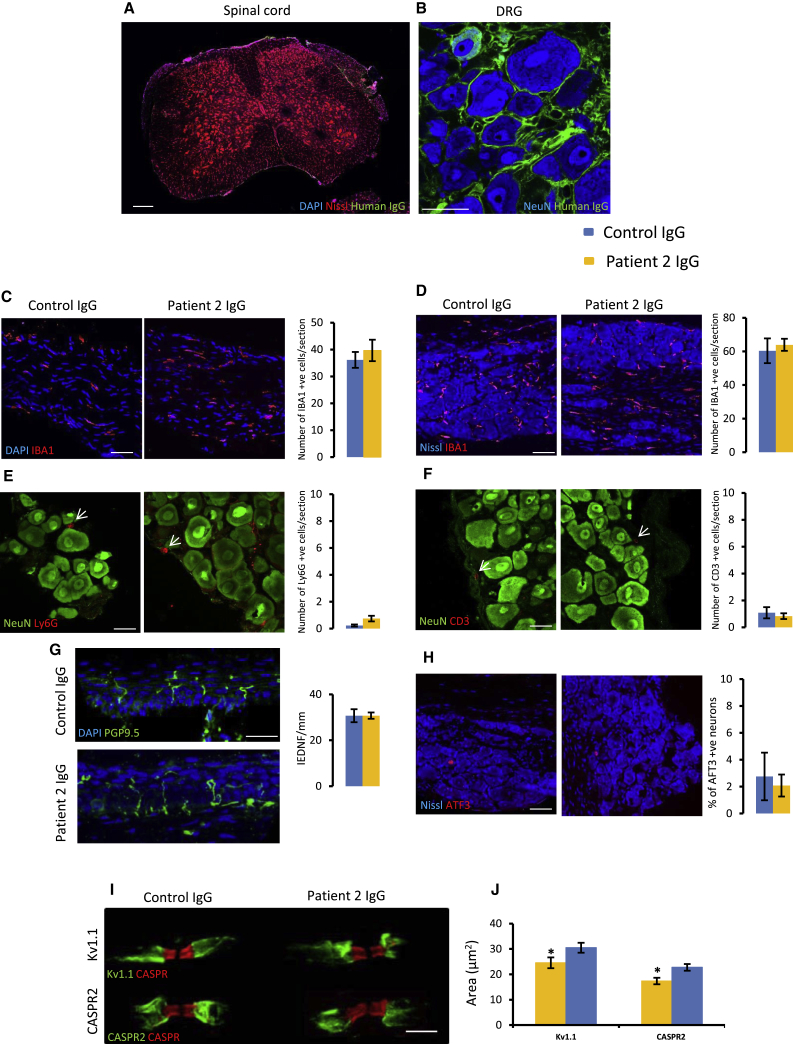
Patient CASPR2-Abs Bind In Vivo but Do Not Cause Gross Inflammation or Nerve Damage(A and B) Representative image of a spinal cord (A) and DRG (B) section from a mouse treated with patient IgG. No deposition of human IgG (green) seen in the spinal cord (A). In the DRG, human IgG binds to sensory neurons (B). Scale bars, 200 μm (A), 50 μm (B).(C and D) Representative images of sciatic nerve (C) and DRG (D) sections from mice treated with either control or patient 2 IgG stained for IBA1 (red). Quantification shows no difference between treatment groups; n = 4 mice. Scale bar, 50 μm.(E and F) Representative images of DRG sections from mice treated with either control or patient 2 IgG stained for Ly6G (red, E) and CD3 (red, F). The number of positive cells was very low, and no difference was found between groups; n = 4 mice. Scale bar, 25 μm.(G) Representative images of mouse glabrous skin. PGP9.5 (green) was used to mark nerve fibers. No difference was seen in the IENFD between treatment groups; n = 5 mice. Scale bar, 25 μm.(H) Representative images of mouse DRG sections stained for the injury marker ATF3 (red). Quantification showed no difference between treatment groups; n = 4 mice. Scale bar, 50 μm.(I and J) High-power representative images of single nodes (marked by CASPR [red]) from mouse sciatic nerve (I). Kv1.1 (green, top) and CASPR2 (green, bottom) staining is reduced in mice treated with patient 2 IgG. Quantification shows a significant reduction in the area of both Kv1.1 and CASPR2 staining in the patient IgG group versus control (J); n = 4 mice.Data shown as mean ± SEM, ∗p < 0.05 versus control IgG group. See also Figures S2–S4.